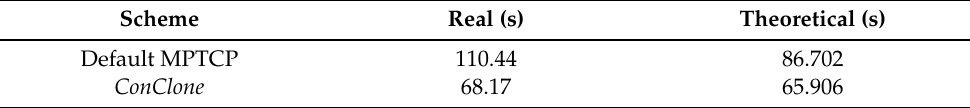
Figure 12. Completion times of all control packet transmissions. Table 3. A comparison of real and theoretical completion